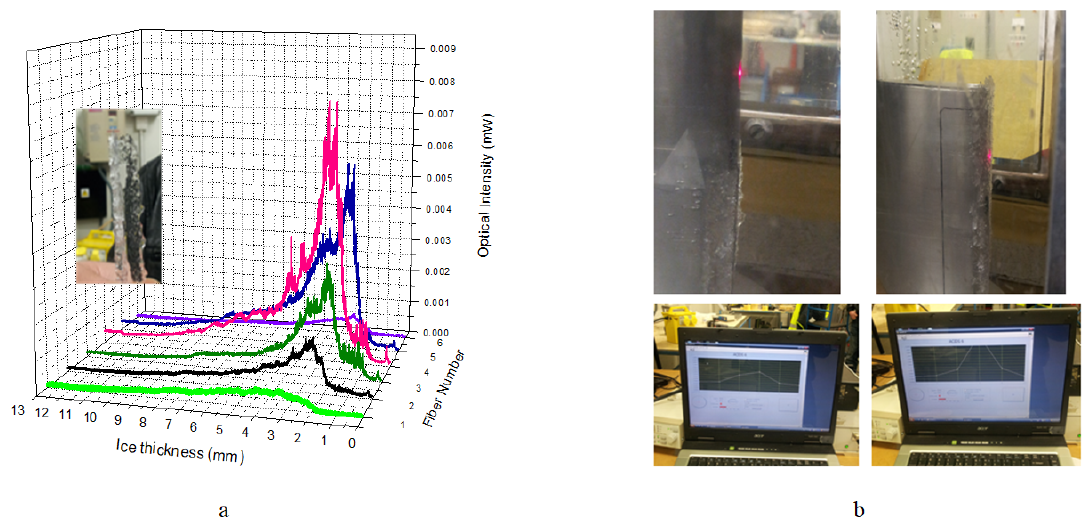
Figure 7. Shadowgraph calibration. The black trace shows the beam blockage, and the red trace is for convenience I = (I 0 − I x ).